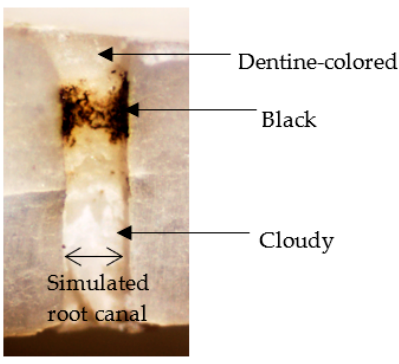
Figure 3. Classi fi cation of simulated root canal wall by discoloration.